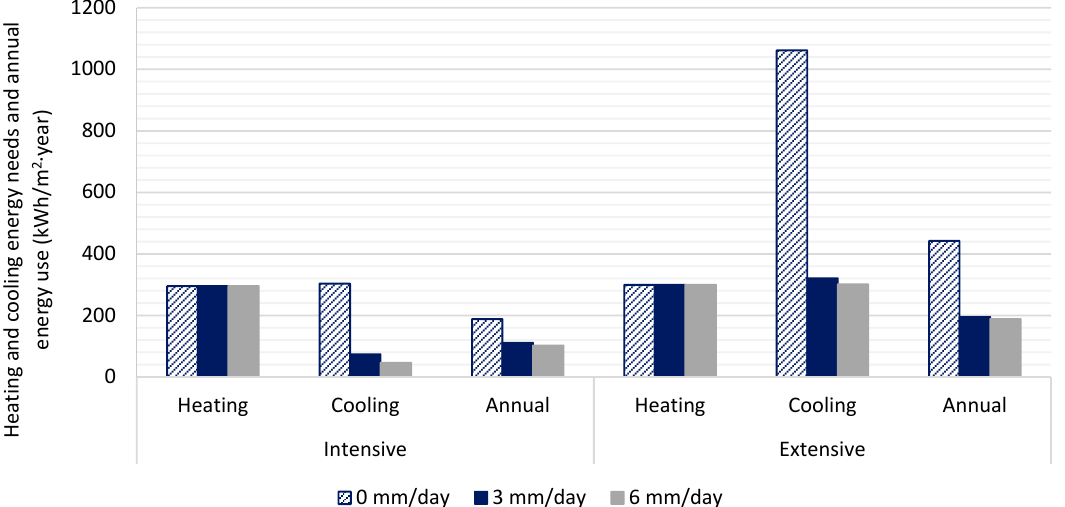
Figure 10. Impact of irrigation variation on heating and cooling energy needs for annual energy use for intensive and extensive green roof solutions.